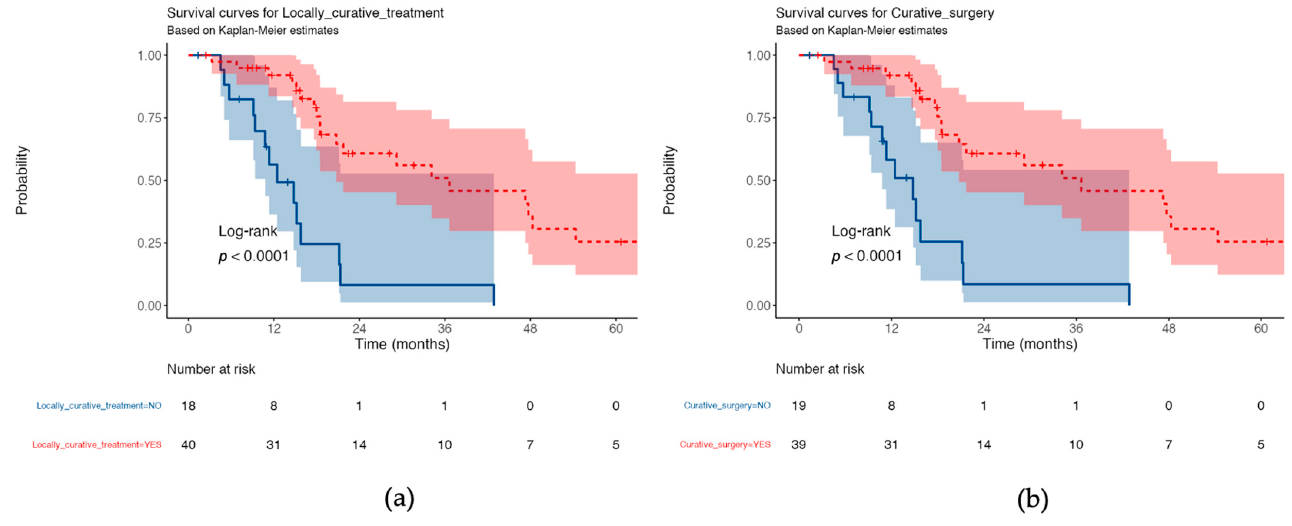
Figure 2. Overall survival curves with 95% confidence intervals for all enrolled patients: ( a ) locally curative treatment vs. no locally curative treatment; ( b ) curative surgery vs. no curative surgery.